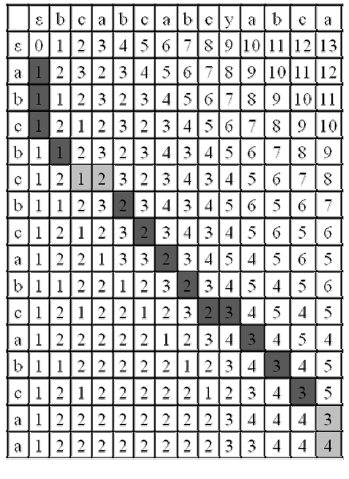
Figure 2. Dynamic Table for the Edit Distance of Block Deletions and Character Moves for the strings S = abcbcbcabcabcaa and T = bcabcabcyabca